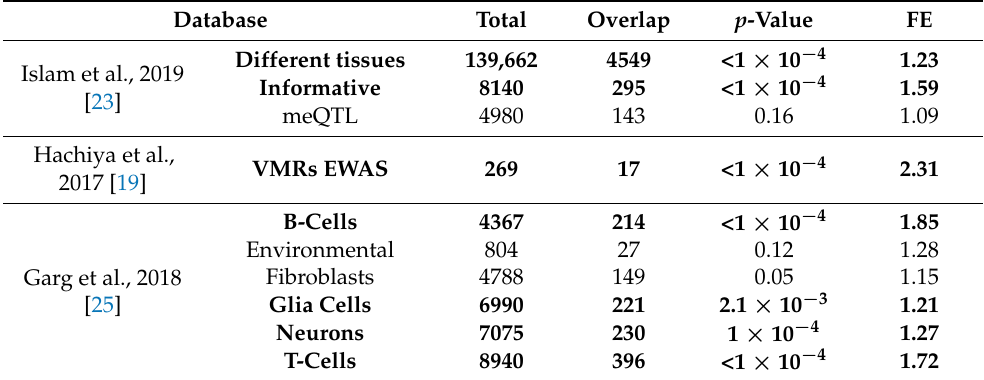
Table 2. Comparison of 11,879 DMPs with VMRs